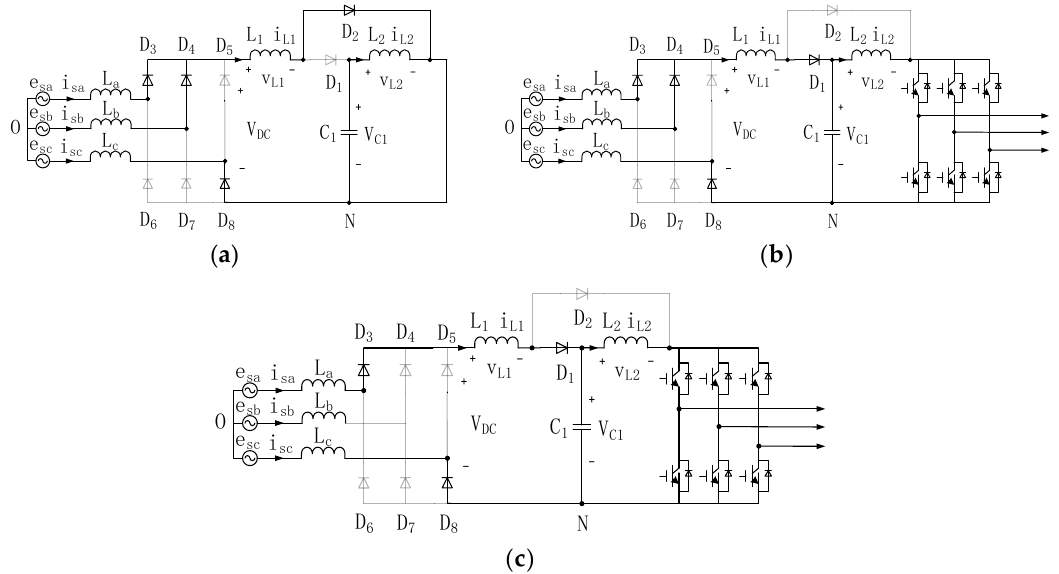
Figure 8. The equivalent circuit of half quasi-Z-source inverter (H-qZSI) wind power generation system in each modes. ( a ) Mode 1; ( b ) Mode 2; ( c ) Mode 3.